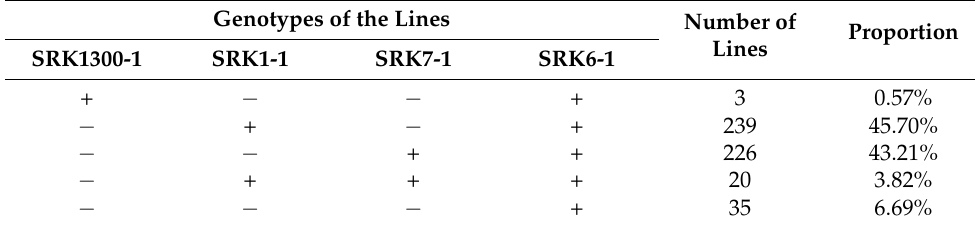
Table 2. Genotype statistics of 523 B. napus cultivars and inbred lines. Genotypes of the